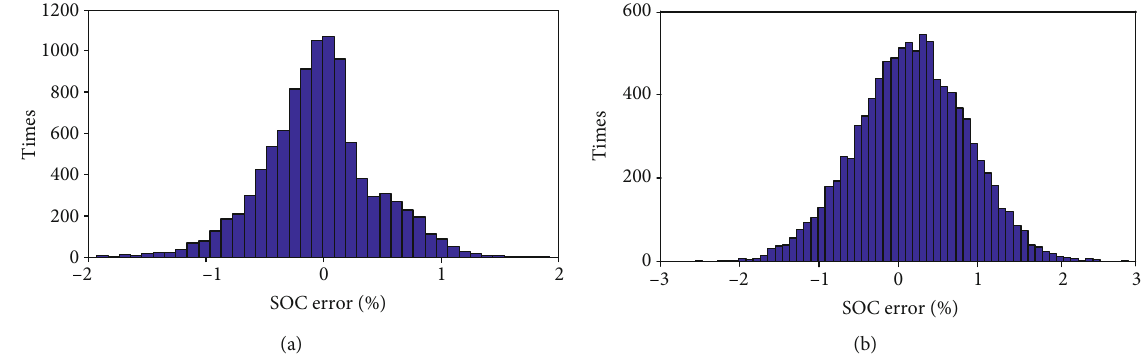
Figure 6: (a) Error distribution of experiment 1. (b) Error distribution of experiment